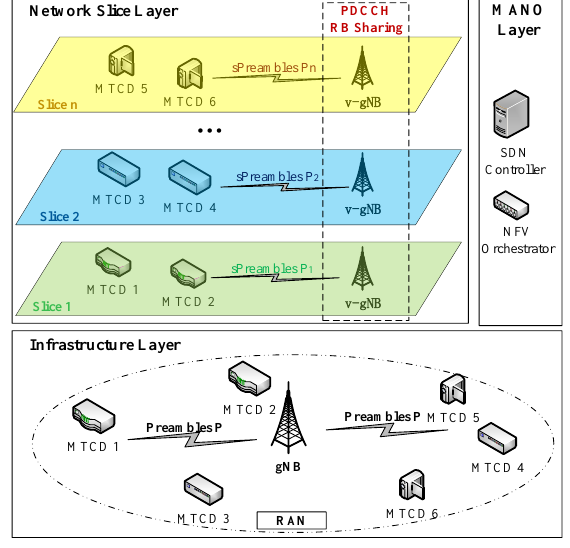
Figure 1. Architecture of the network slicing-enabled RA framework for